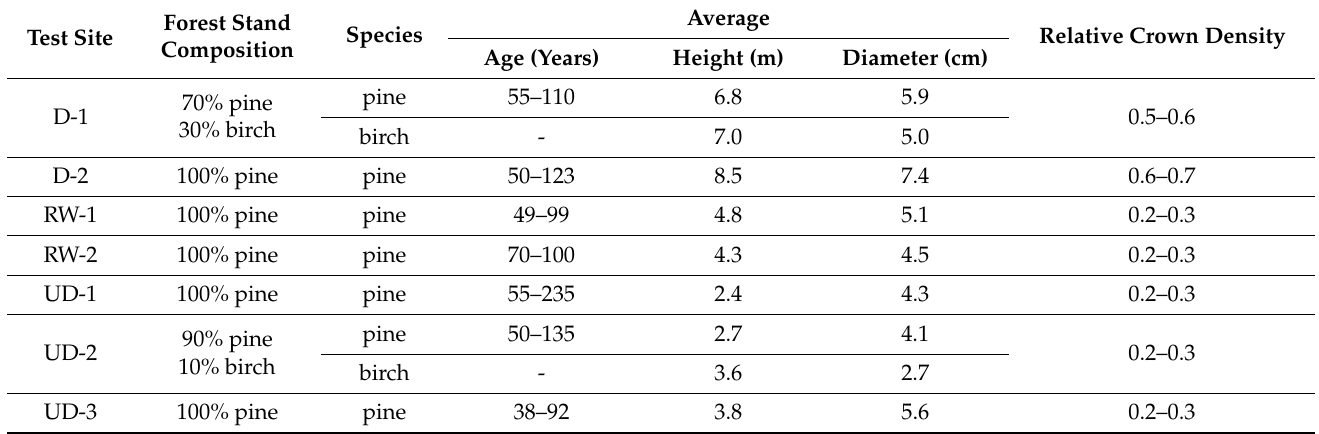
Table 1. Properties of the forest stand of test